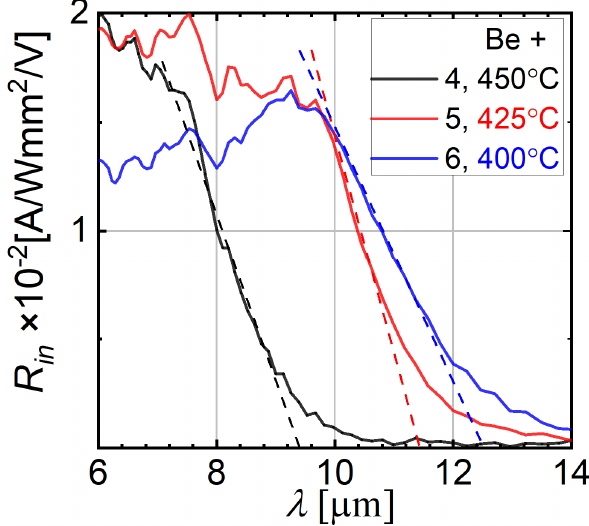
Figure 7. Spectral response characteristic at 210 K for T2SLs from Set I (samples 4, 5, and 6). We calculated the energy bandgap dependence versus strain in T2SLs InAs/InAsSb (sam- ples 4, 5, and 6) based on an 8 × 8 kp solver. The results are presented in Figure 8.